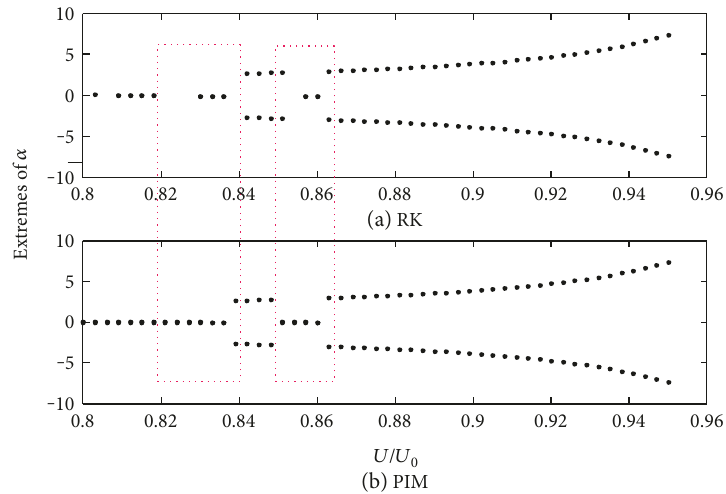
Figure 5: Bifurcation charts of the aeroelastic system obtained by RK (a) and PIM (b) with Δ t = 0 1 , respectively. Major di ff erences are boxed by red dashed lines.